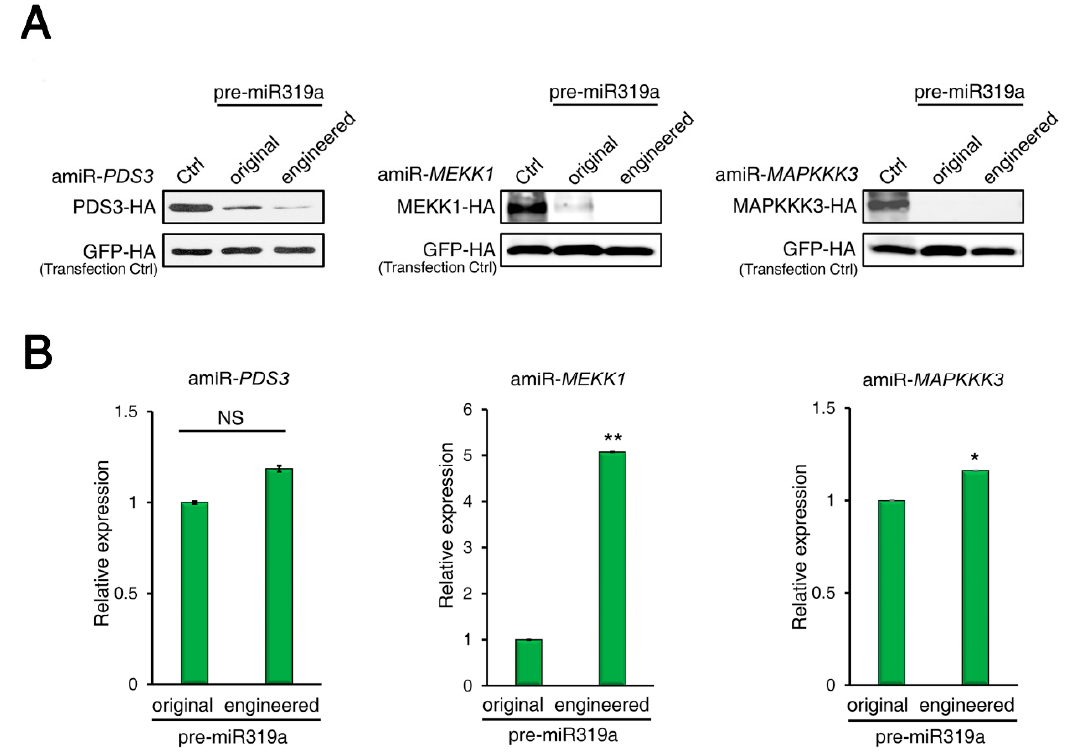
Figure 3. amiRNAs produced from engineered pre-mir319a exhibit equal efficacy in silencing target gene expression. ( A ) Comparison of the performance of amiRNAs produced from the original or engineered pre-miR319a using the ETPamir assay. amiRNAs expressed from engineered pre-miR319a are slightly more effective in silencing Arabidopsis PDS3 , MEKK1 , and MAPKKK3 expression than those expressed from original pre-miR319a in protoplasts. Three independent repeats with GFP-HA as an untargeted internal control produced similar results. ( B ) Detection of mature amiRNAs produced from the original or engineered pre-miR319a in the ETPamir assay. Mature amiRNAs were detected using stem-loop RT-qPCR. The quantitative PCR data represent means ± SD of at least three independent repeats using mCherry-HA as a transfection control. * p < 0.05, ** p < 0.01 (student’s t